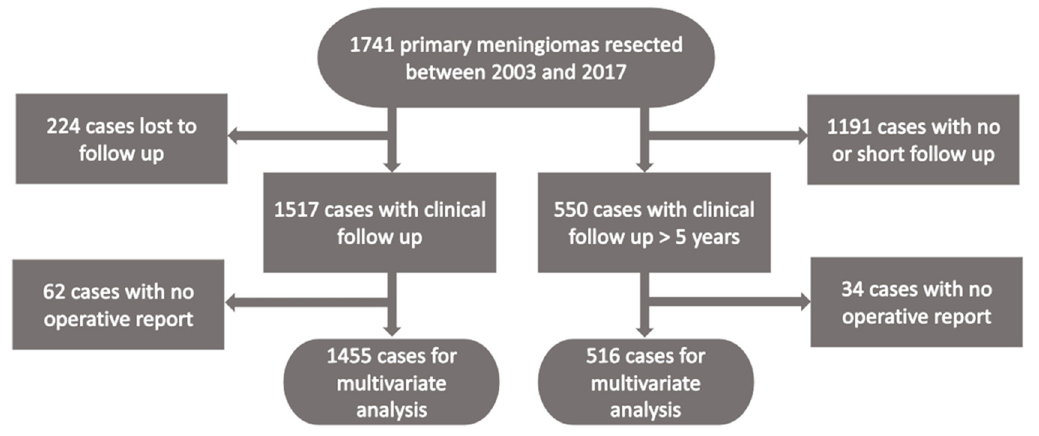
Figure 5. Flow chart of the study cohort.